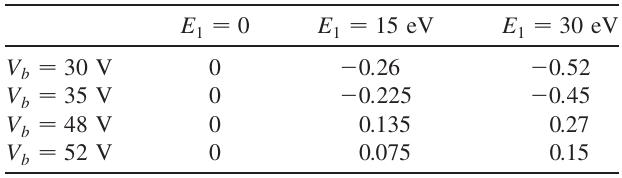
TABLE III. Values of (cid:5) factor for different beams when assuming different initial energy perturbation amplitude E 1 .